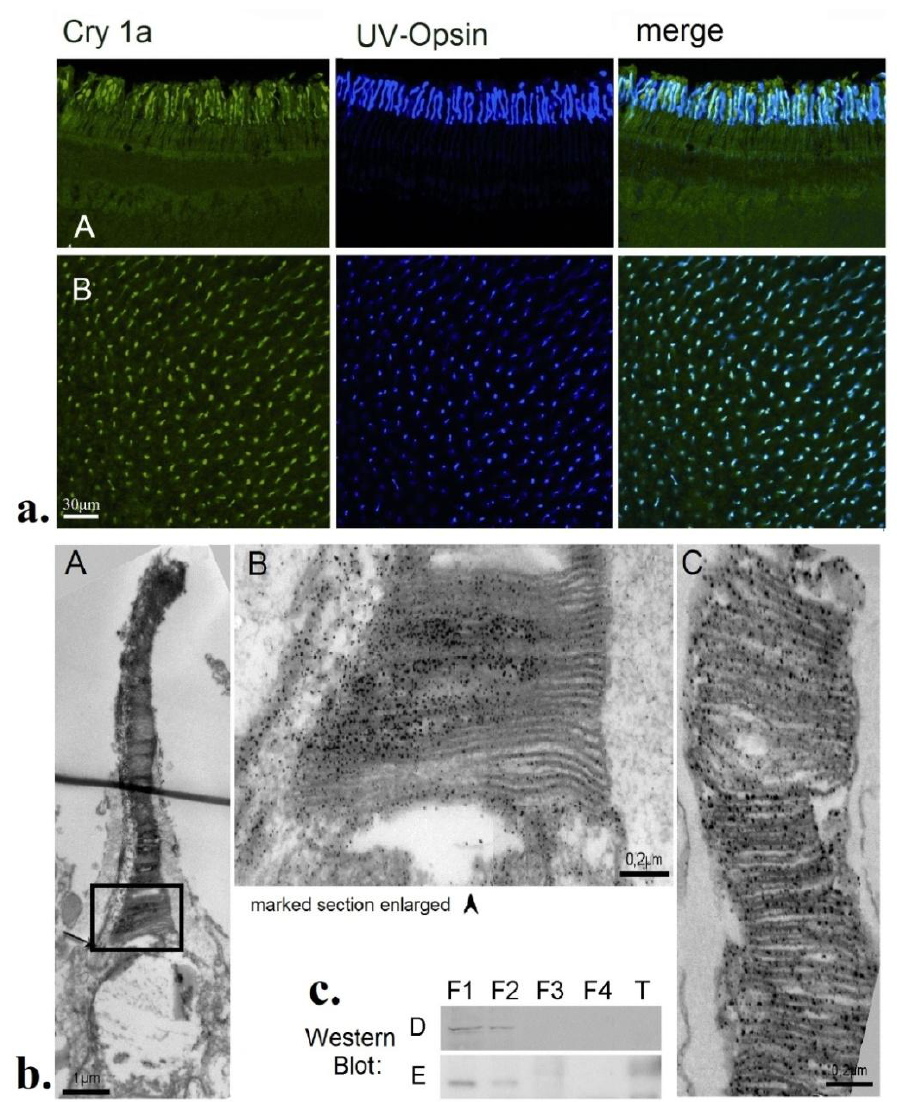
Figure 8. Localization of cryptochrome 1a (Cry1a) in the retina of robins and chickens. ( a ) Immuno-labeling of Cry1a and UV-opsin and their co-localization in the retina of robins. A, Vertical section through the outer part of retina; B, whole mount of a retina. ( b ) Electron-microscopic images of the outer segments of the UV/V-cones, with labeled Cry1a visible as dark dots along the disk membranes. A, entire outer segment of a chicken V-cone. B, higher magnification of the lower part of this outer segment. C, Part of the outer segment of an UV-cone of a robin. ( c ) Western blots of robin (D) and chicken (E) retina showing Cry1a in the cytosol and membrane fraction. F1, cytosolic fraction; F2, membrane fraction; F3, nuclear fraction; F4, cytoskeletal fraction; T, tongue tissue as control (from